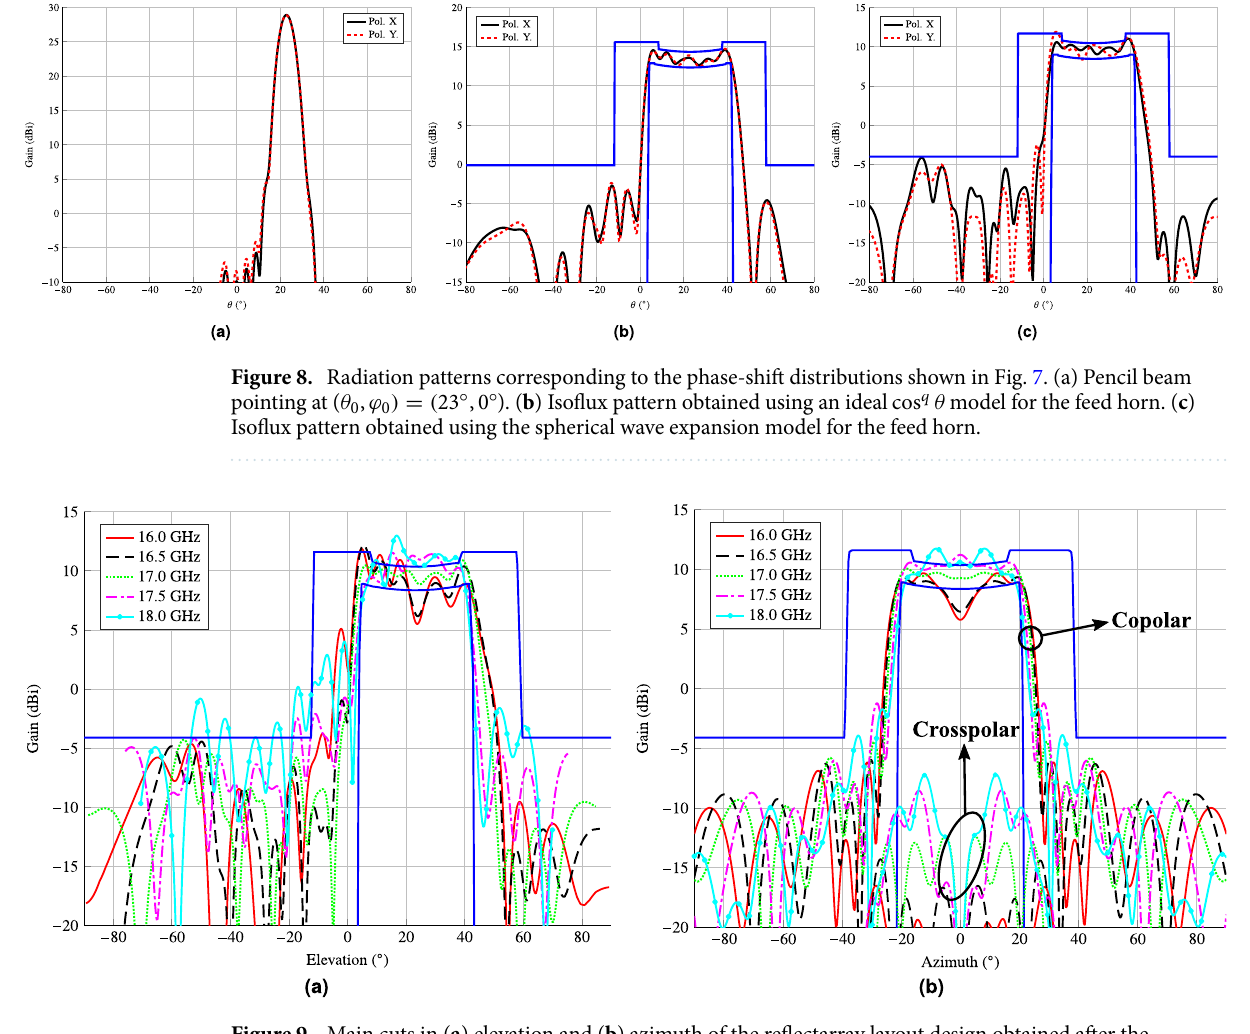
Figure 9. Main cuts in ( a ) elevation and ( b ) azimuth of the reflectarray layout design obtained after the phase-only synthesis. This design complies with specifications at central frequency (17 GHz), but due to its narrowband nature, it does not comply in the rest of the band. Due to the symmetry in the antenna optics, there is a null in the crosspolar pattern in the elevation